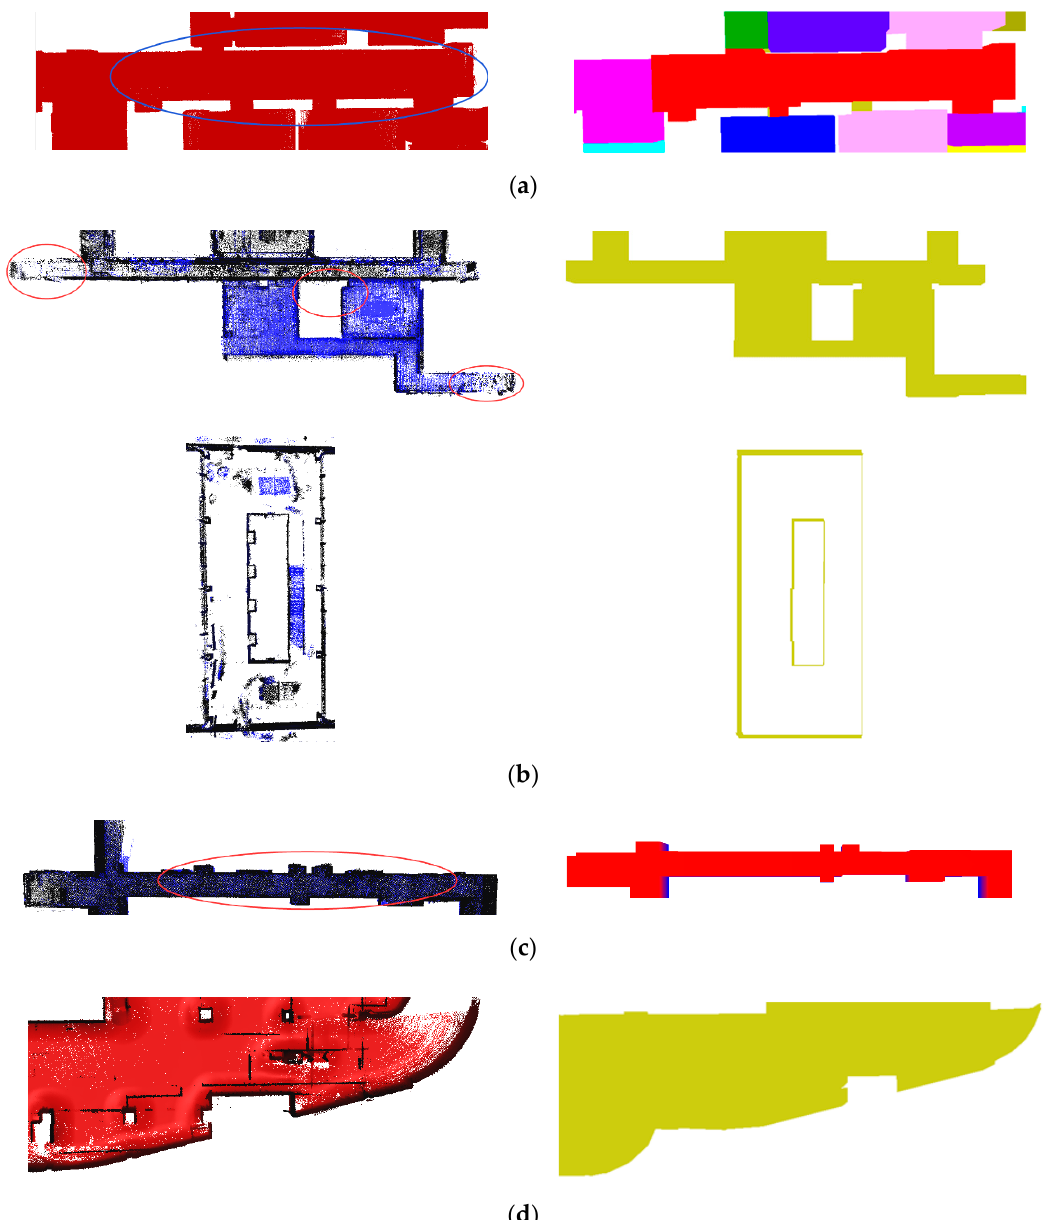
Figure 21. Close-up views of selected details. ( a ) Benchmark point clouds and reconstructed model. ( b ) The point clouds and reconstructed model of the corridor at the Shenzhen University. ( c ) The point clouds and reconstructed model of the corridor at Xiamen University. ( d ) The point clouds and reconstructed model of the parking lot at Xiamen University.